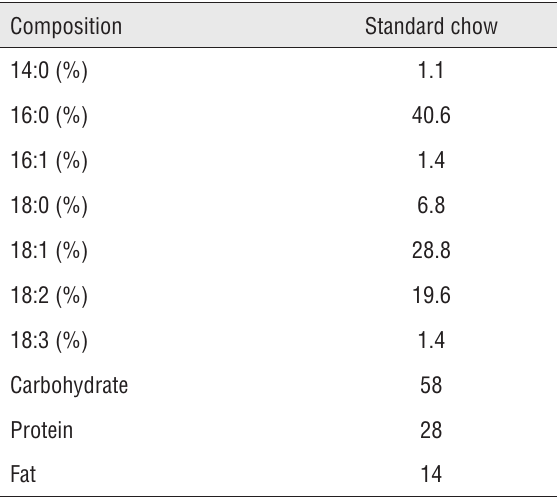
Table 1 - Fatty acid composition of standard chow